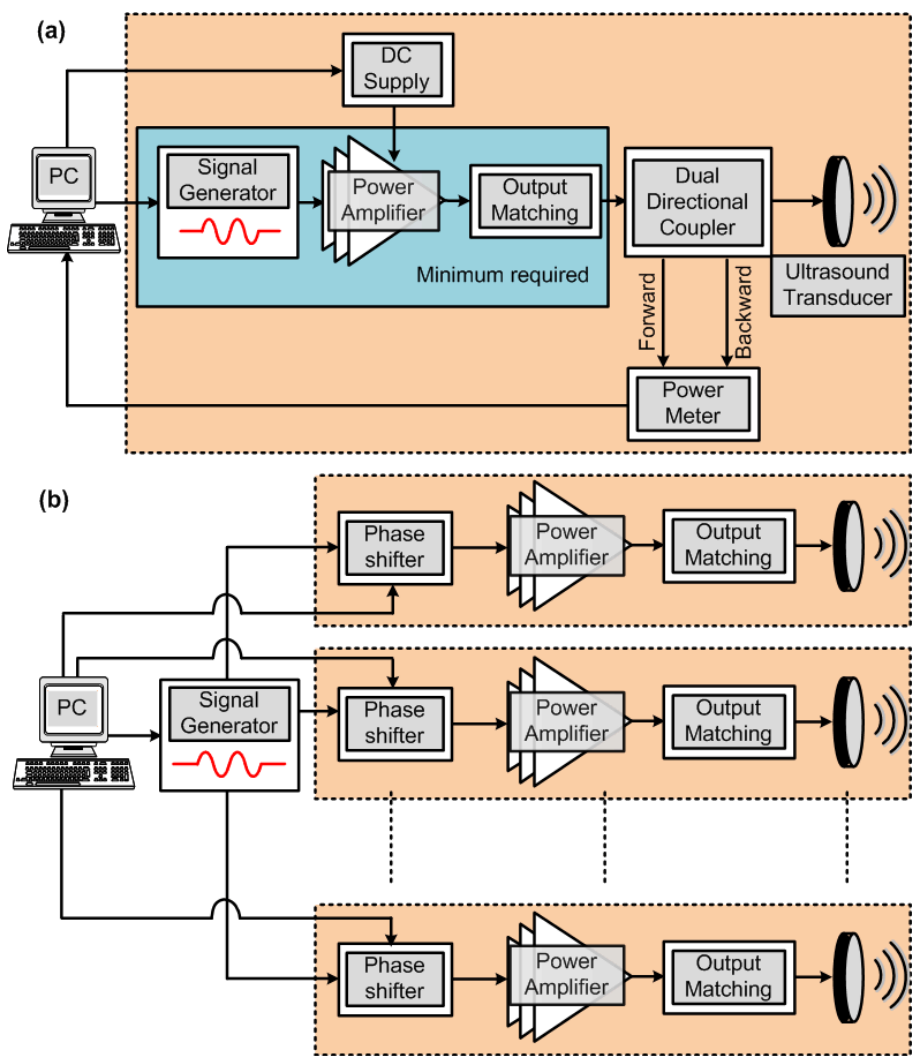
Figure 1. (a) A block-diagram of a typical single-element HIFU system. If used in an n -element system, the area enclosed in the dashed line should be repeated n times. (b) A more practical multi-element implementation that employs phase